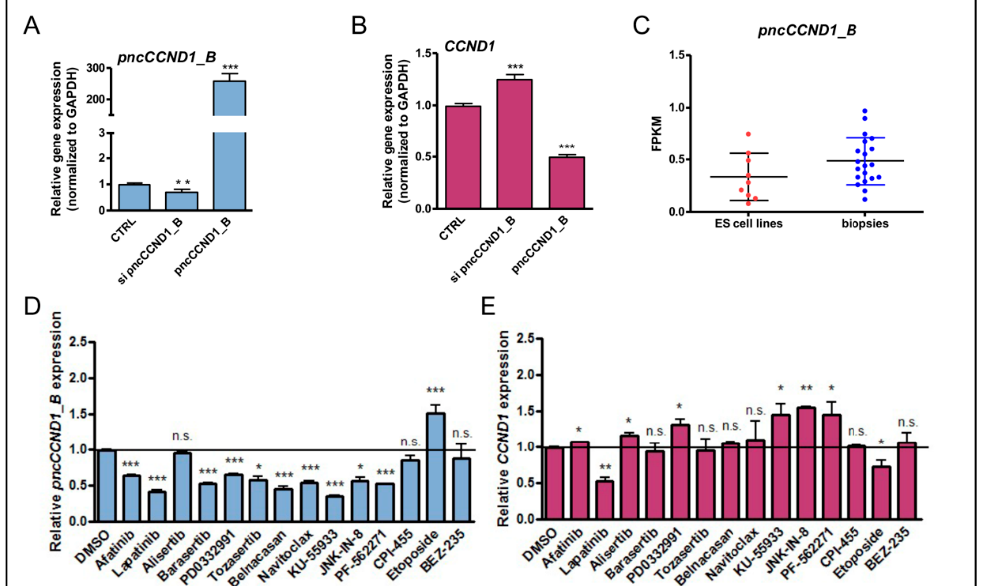
Figure 1. Pan-inhibitor screening unveils etoposide as a modulator of pncCCND1_B expression. The expression of pncCCND1_B ( A ) and CCND1 mRNA ( B ) was monitored in TC-71 Ewing sarcoma cells after transfection with either the control or sipncCCND1_B oligonucleotides or in vitro transcribed pncCCND1_B . Histograms represent three independent experiments (± S.D.). Statistical analysis was performed by the Student’s t -test versus CTRL. p -value (* <0.05, ** <0.01, *** <0.005). ( C .) Expression levels of pncCCND1_B were evaluated in a dataset derived from an RNA-sequencing experiment of a total of 20 Ewing sarcoma patients and nine Ewing sarcoma cell lines (dbGaP accession phs000804.v1.p1) [7,36]. The expression of pncCCND1_B ( D ) and CCND1 mRNA ( E ) was monitored in TC-71 Ewing sarcoma cells after different 16 h drug treatments. Histograms represent three independent experiments (± S.D.). Statistical analysis was performed by the Student t -test versus DMSO. p -value (* < 0.05, ** < 0.01, *** < 0.005).